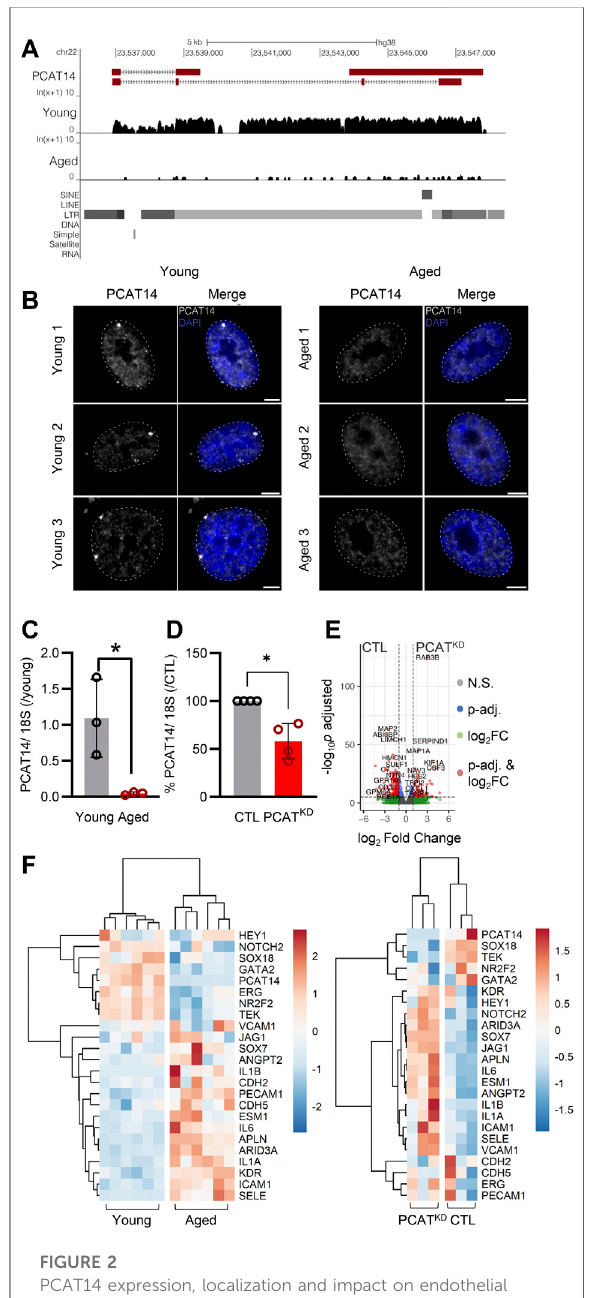
FIGURE 2 PCAT14 expression, localization and impact on endothelial cell transcriptome. (A) UCSC Genome Browser showing the PCAT14locus(hg38)andthepoly(A)+RNA-seqtracksfromyoung and aged human native endothelial cells. (B) Maximum intensity projections of representative images of PCAT14 smRNA FISH on young and aged human native endothelial cells. Exon, gray;nucleus,blue,outlinedwithadashedcircle.Scalebar=5 μ m. RNA FISH was performed on 7 young and 4 aged samples. (C) RelativelncRNAlevelsofPCAT14inyoungandagednativeisolated arterial endothelial cells ( n =3 per group, * p < 0.05, Student ’ s t-test). (D) Relative PCAT14 expression normalized to CTL in Human umbilical vein endothelial cells (HUVEC, Passage 3) were transfected with GapmeR (50 nmol/L, 72 h) targeting PCAT14 (PCAT KD ) or a respective control (CTL). (E) Representative volcano plots showing differentially expressed transcripts (total variables